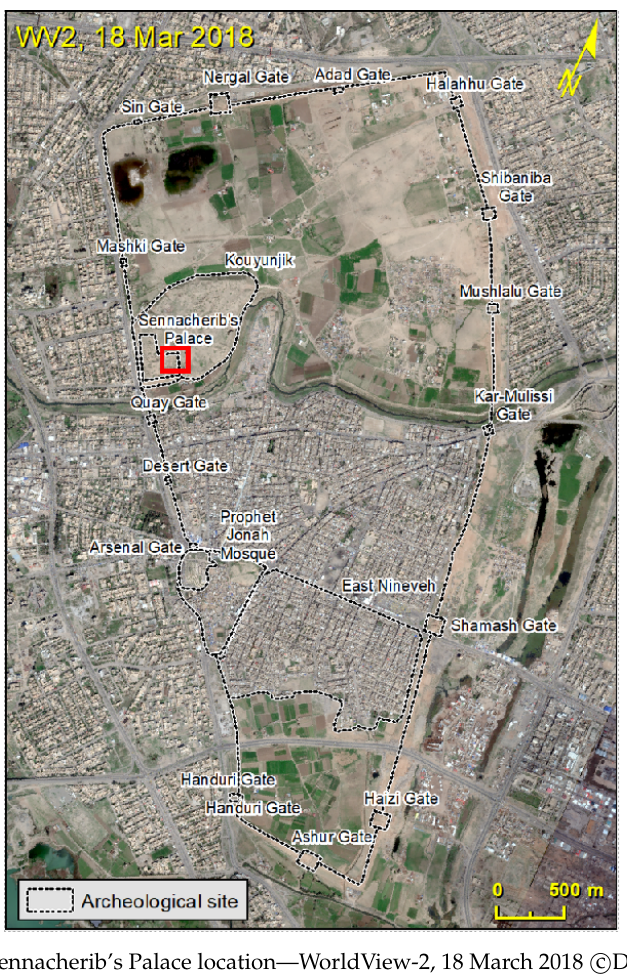
Figure 18. Sennacherib’s Palace location—WorldView-2, 18 March 2018 c (cid:13) DigitalGlobe.